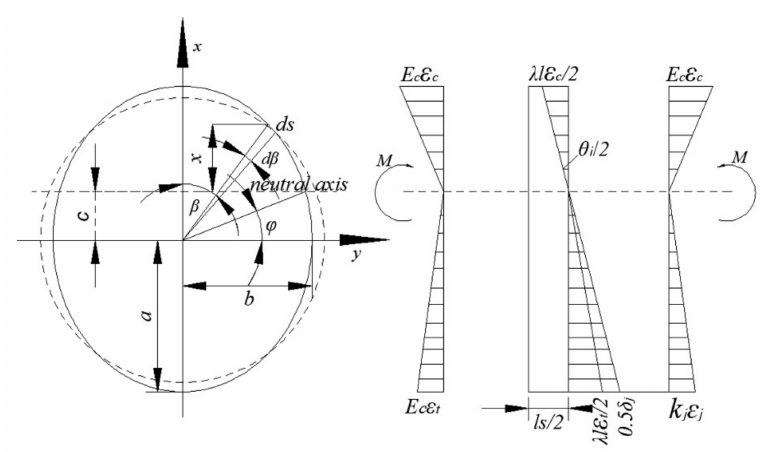
Figure 1. Diagram of stress and deformation of the lining within the influence range of annular gaps [16].